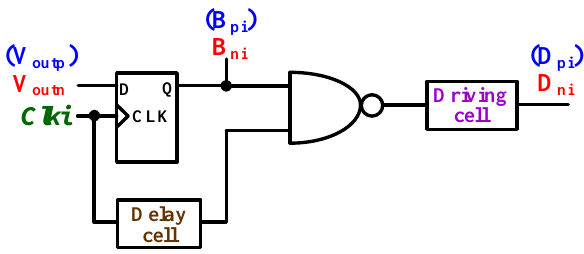
Figure 11. Modified DAC control circuit with V outn / V outp , Clki, B ni / B pi , and D ni / D pi .